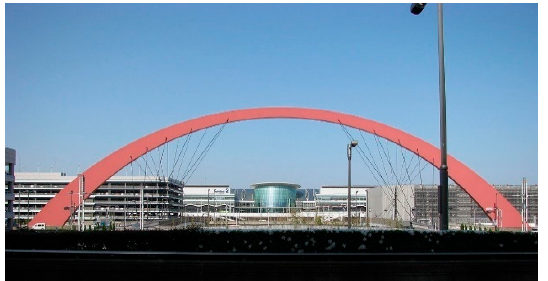
Figure 7. Haneda Sky Arch (photo: Aimaimyi, Wikimedia Commons).